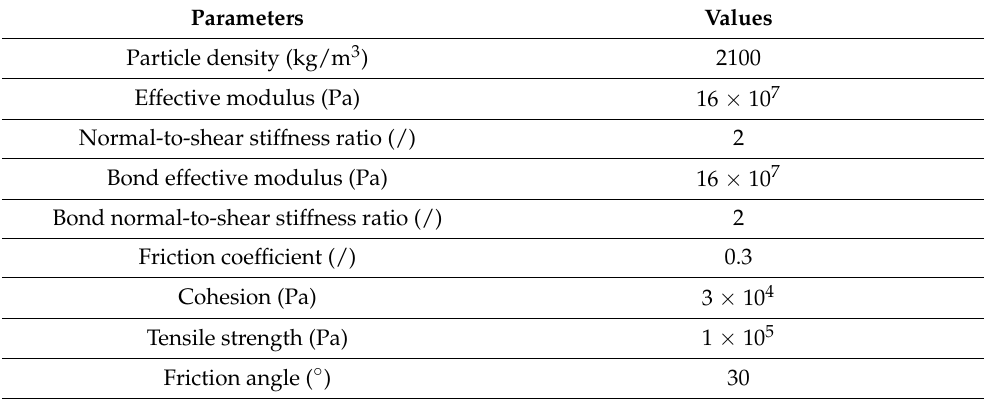
Table 1. Parameters used in the numerical